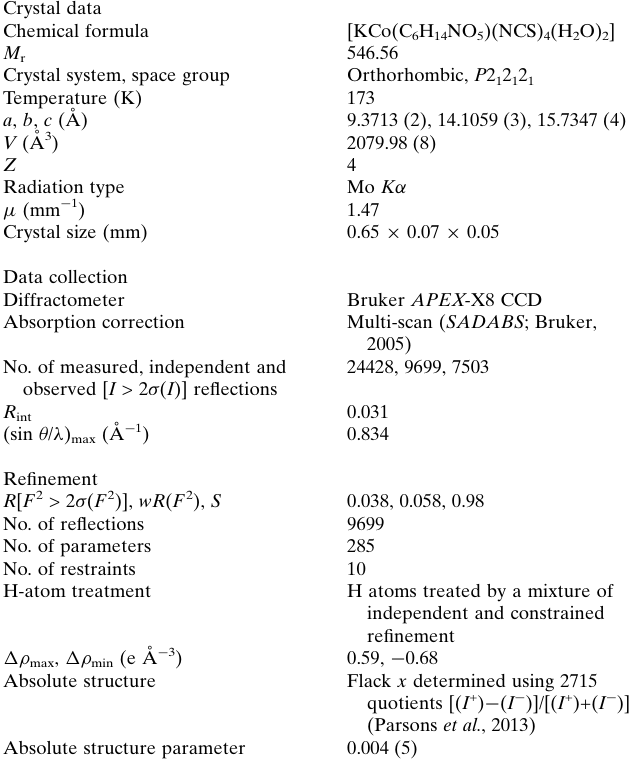
Crystal data Chemical formula